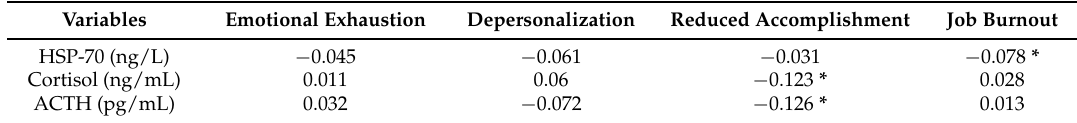
Table 4. Correlation between job burnout and neuroendocrine indicators in the arid desert group. Variables Emotional Exhaustion Depersonalization Reduced Accomplishment Job Burnout HSP-70 (ng/L) ´